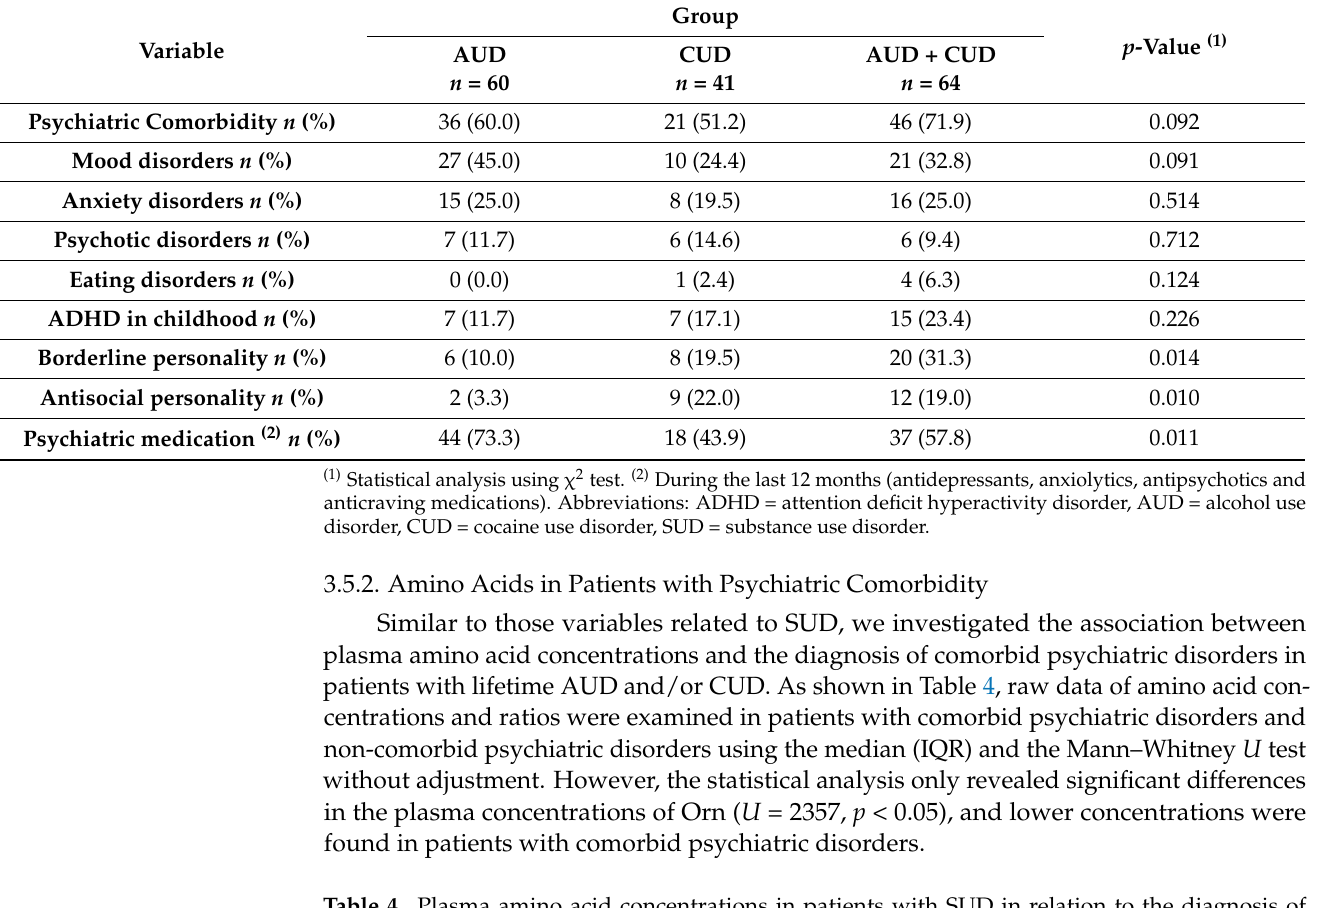
Table 4. Plasma amino acid concentrations in patients with SUD in relation to the diagnosis of psychiatric